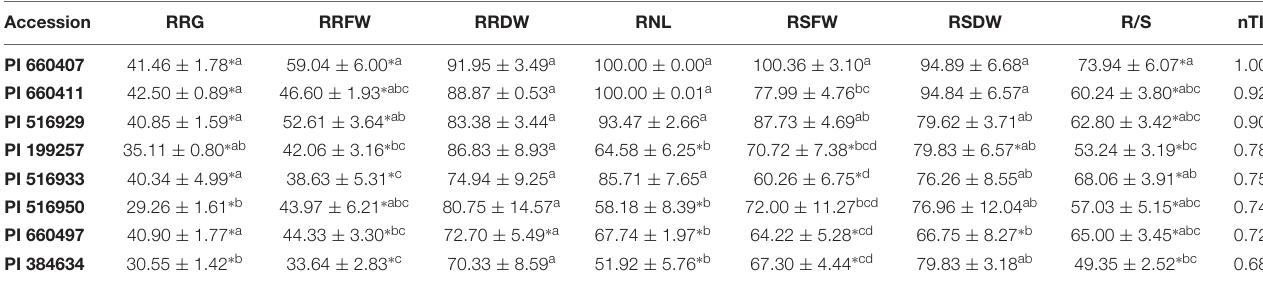
TABLE 1 | Relative growth parameters and normalized tolerance indices for selected M. truncatula accessions grown in hydroponic pouches with 0 or 100 µ M CdCl 2 for 12 days.